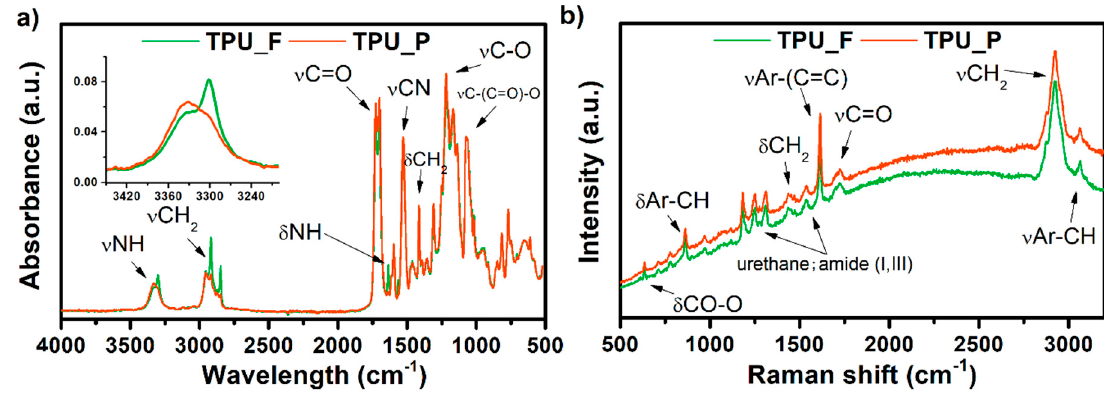
Figure 3. FTIR ( a ) and Raman ( b ) spectra of obtained TPU filament and printout.